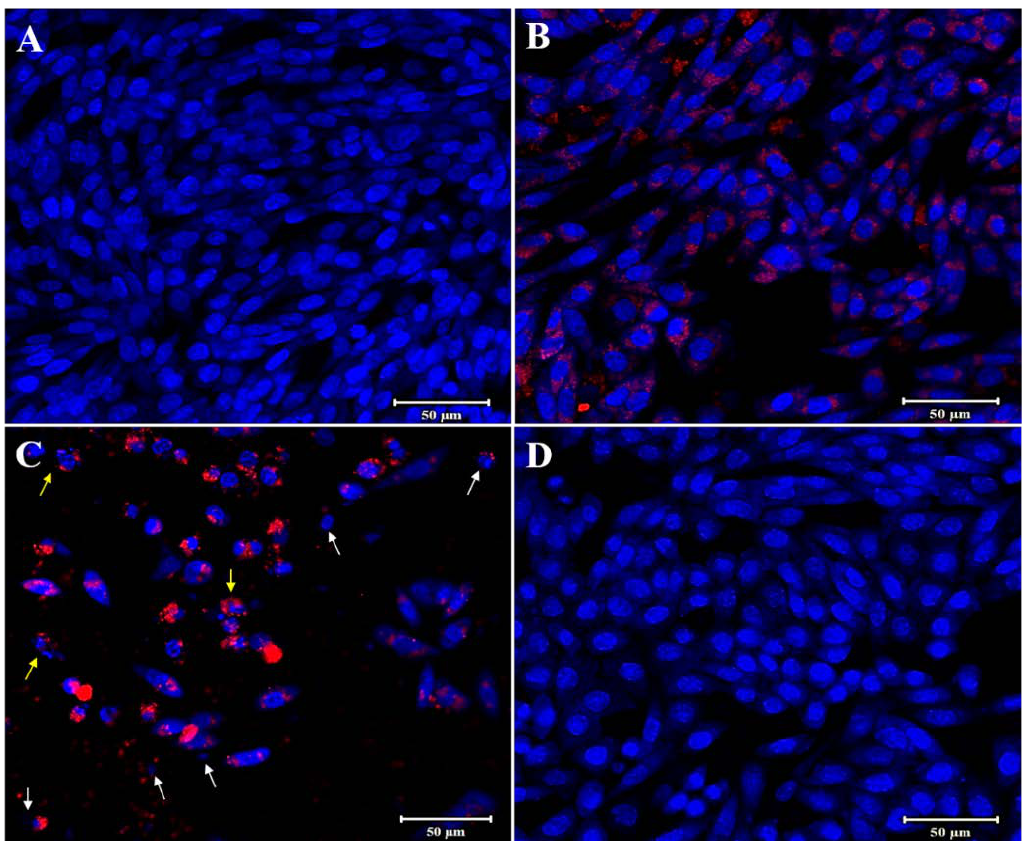
Figure 10. Confocal laser scanning microscopy images of HFF-1 cells after 24 h of treatment. In the images, NR is shown in red color and the nucleus is stained with Hoechst in blue. ( A ) Control (no treatment), ( B ) PMMA-NR treatment (37.36 µ g / mL), ( C ) PMMA-NR-Si-TAM treatment (37.36 µ g / mL), ( D ) TAM treatment (37.36 µ g / mL). The arrows indicate the nucleus structural changes. White arrow: